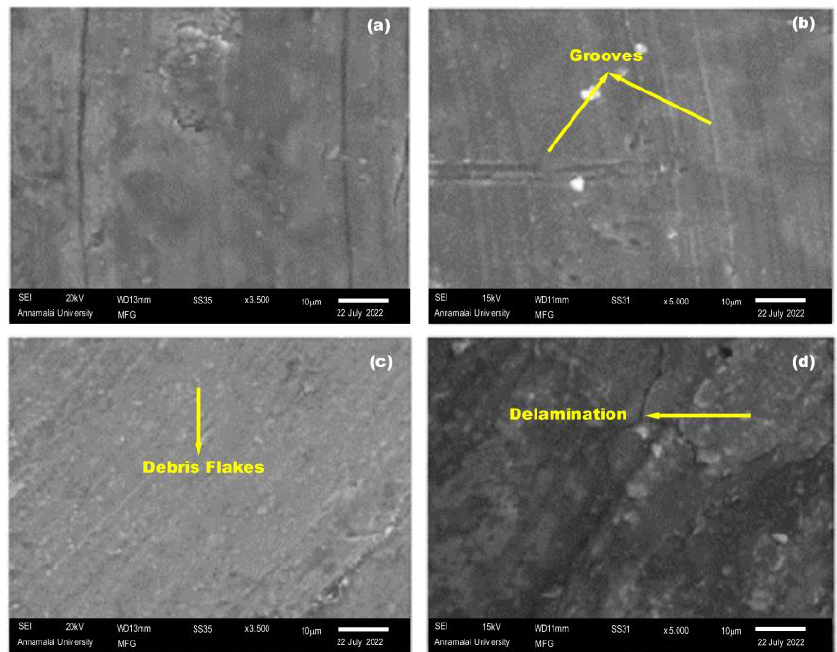
Figure 18. Micrographs showing worn-out surfaces of TiB 2 -30Si 3 N 4 -3B 4 N at: ( a ) 6 N, ( b ) 12 N, ( c ) 18 N, and ( d ) 24 N.